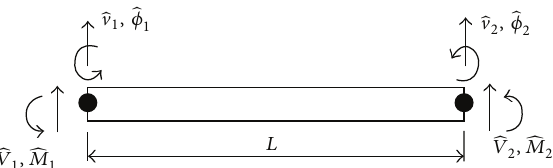
Figure 2: Two-node undamaged beam spectral element. model with two degrees of freedom by nodes ( ̂ V and ̂𝑉 ̂𝑀 nodal loads ( and